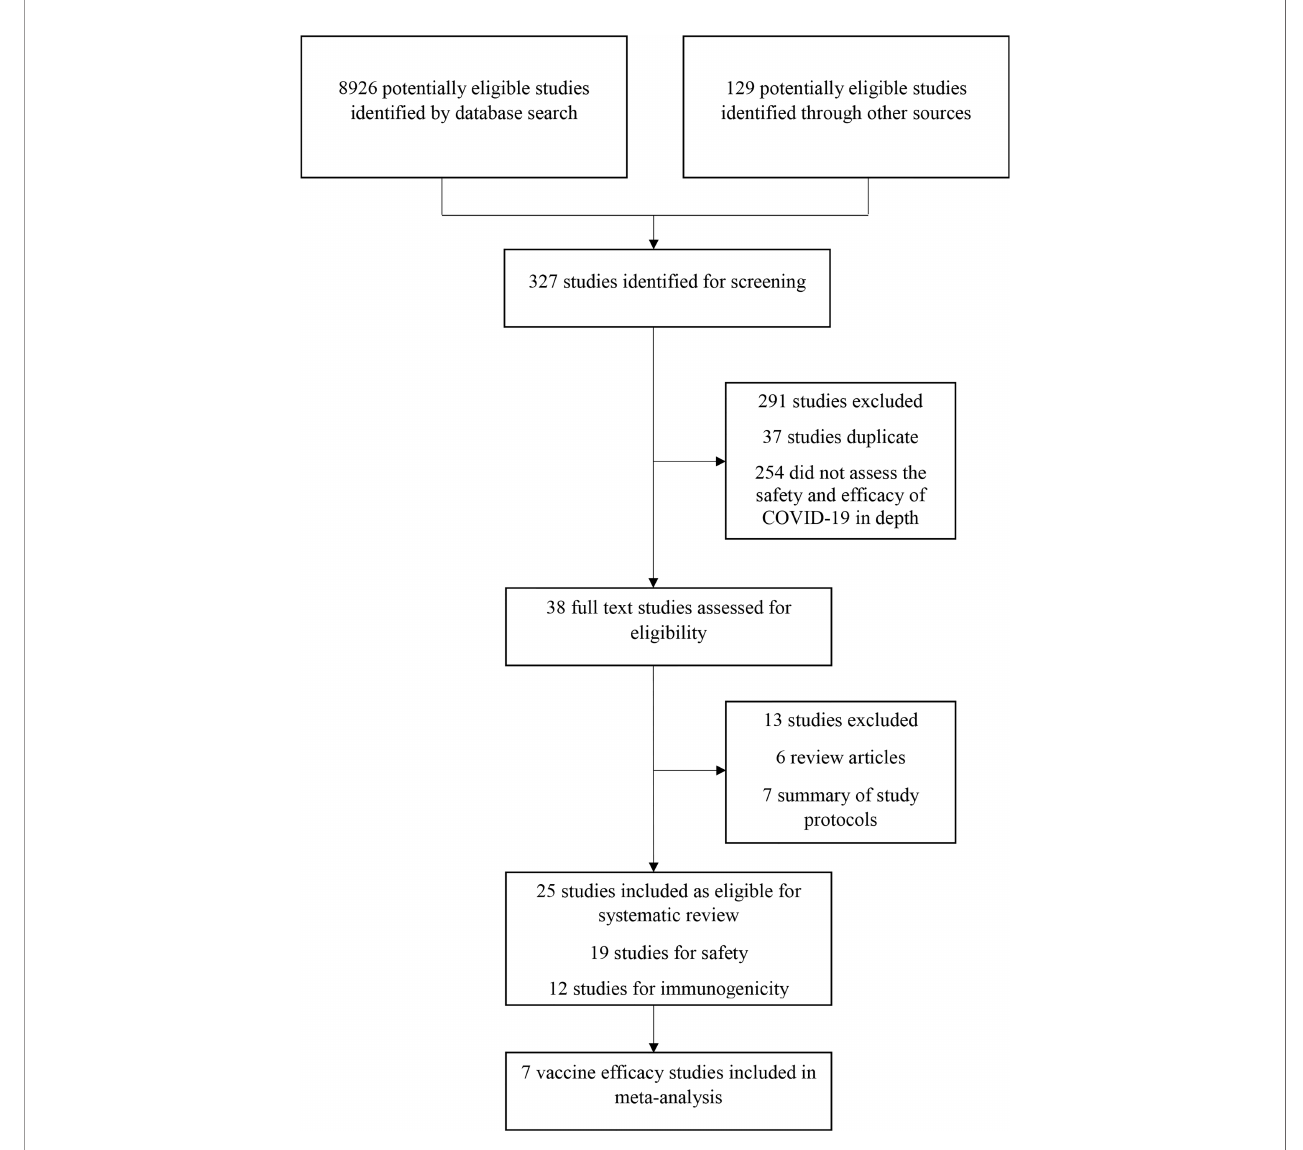
FIGURE 1 | Study selection